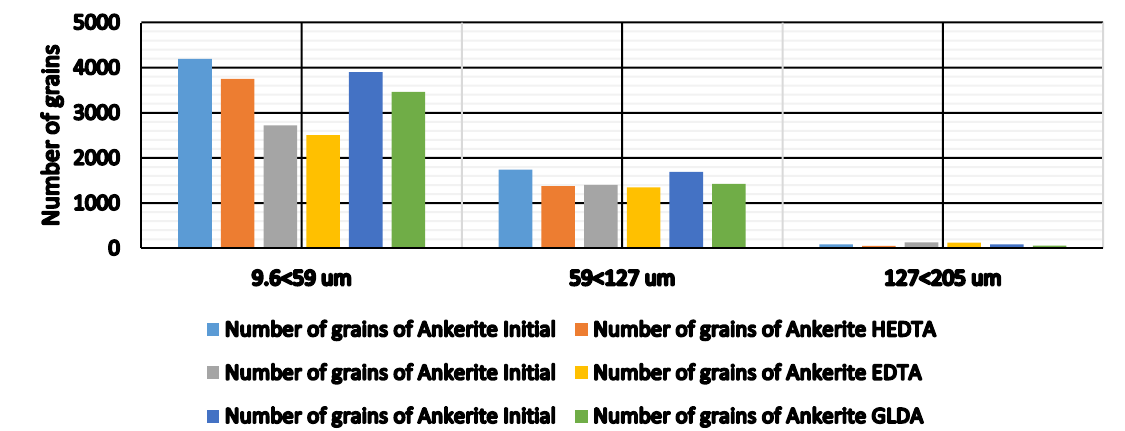
Fig. 16 The grain size distribution of ankerite in Colton Sandstone before and after reaction with chelating agents